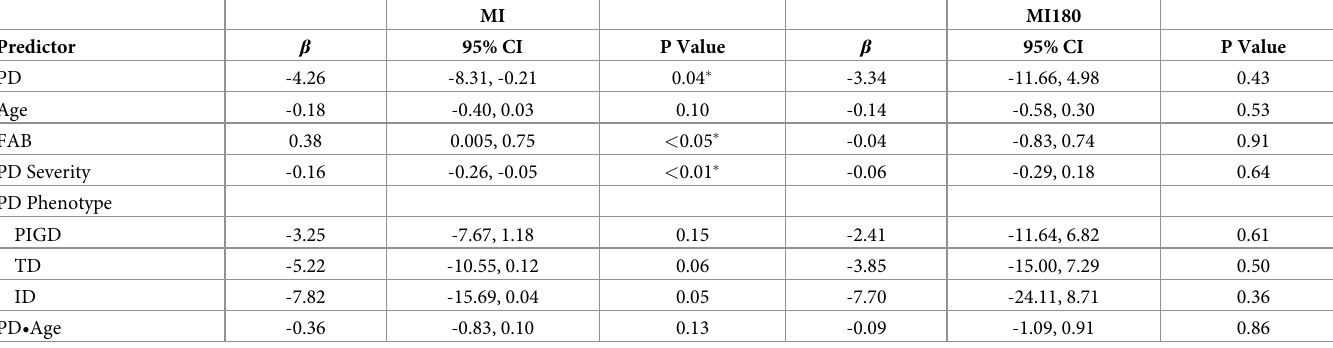
Table 2. Associations between predictors of interest and muscle modulation indices MI and